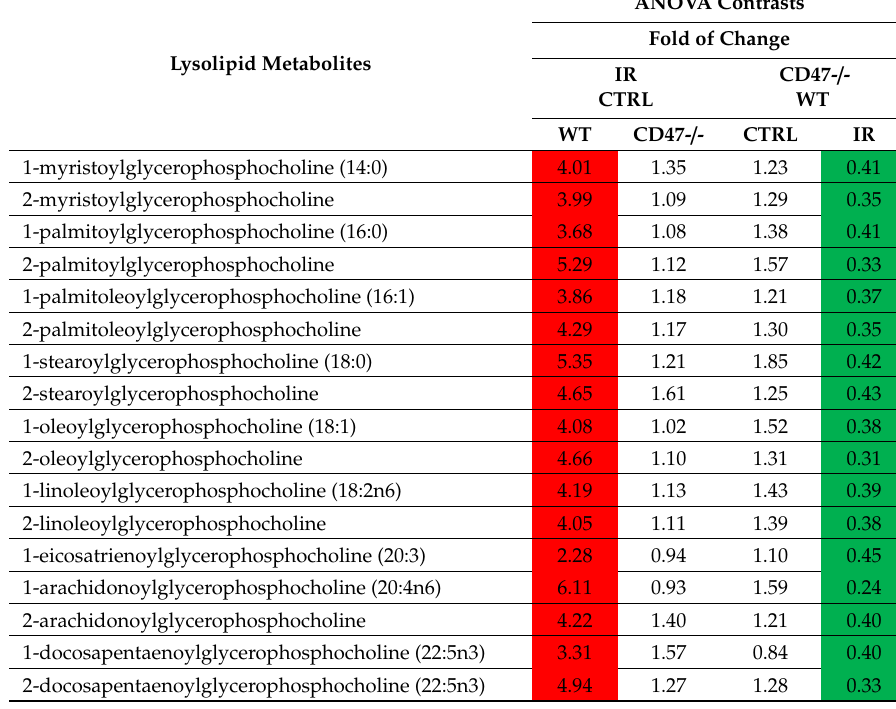
Table 2. Lysolipid metabolites fold